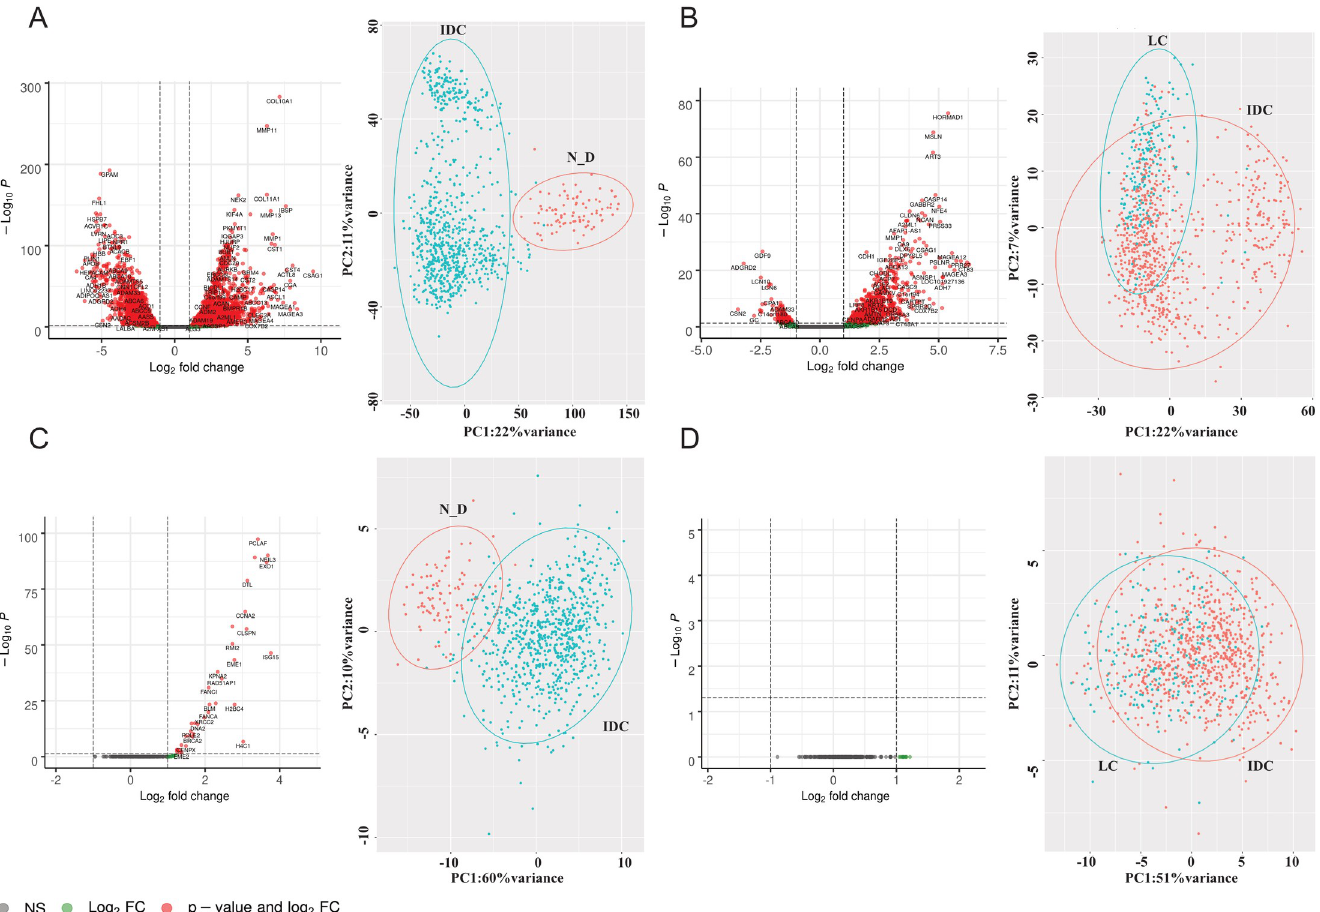
Fig 1. Analysis of DEGs and DNA repair DEGs in IDC and LC. A) Analysis of DEGs in IDC vs Normal_Ductal. Volcano plot of IDC vs Normal_Ductal (25,177 genes). The positive log2 fold change reflects overexpression in IDC when compared to normal_ductal (N_D), and the negative log2 fold change reflects downregulation in IDC in comparison to normal_ductal. PCA of all DEGs (3854 genes) between normal_ductal vs IDC. B) Analysis of DEGs in IDC vs LC. Volcano plot of IDC vs LC (25,177 genes). The positive log2 fold change reflects overexpression in IDC when compared to LC, and the negative values reflect the downregulation in IDC in comparison to LC. PCA of all DEGs (663 genes) between IDC and LC. C) Analysis of DNA repair DEGs in IDC vs Normal_Ductal; Volcano plot of IDC vs Normal_Ductal (285 genes). The positive log2 fold change reflects overexpression in IDC when compared to normal_ductal, and the negative log2 fold change reflects downregulation in IDC in comparison to normal_ductal. PCA of repair DEGs (36 genes) between normal_ductal vs IDC. D) Analysis of DNA repair DEGs in IDC vs LC; Volcano plot of IDC vs LC (285 genes). PCA of repair DEGs (36 genes) between IDC and LC. Color code for the volcano plots: Red; DEGs (| log2FC| > 1 and adjusted P-value < 0.05), Green; (|log2FC| > 1 and adjusted P-value > 0.05), grey; not significant